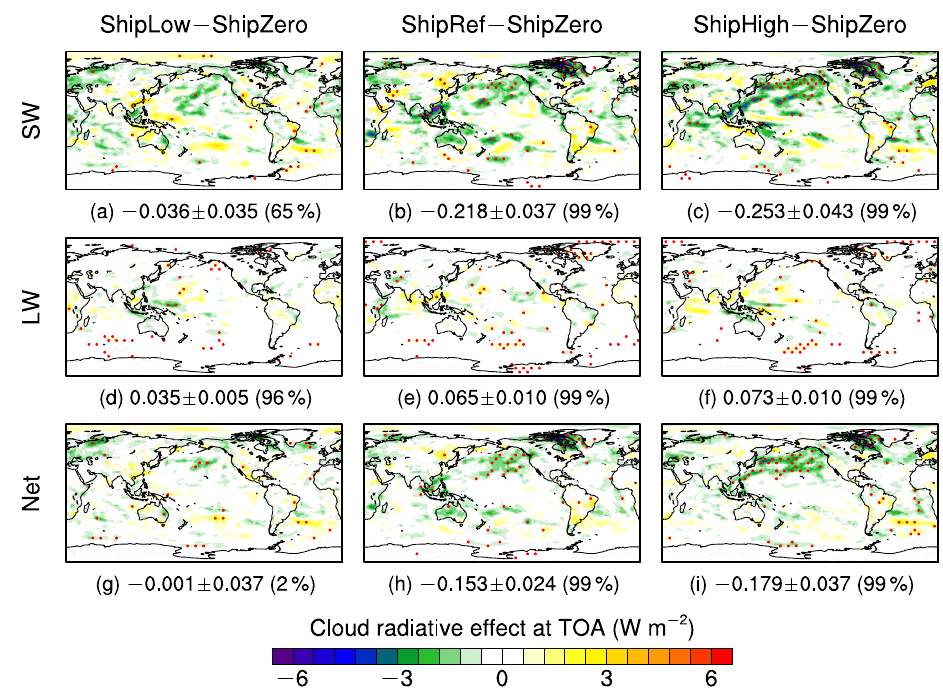
Figure 4. Spatial patterns of MARC-simulated cloud radiative effect (CRE; Wm − 2 ) at the TOA of ISE with various shipping emission levels. The CRE is calculated as the differences of radiation flux at the TOA and at all-sky conditions between the simulation without shipping emissions and three simulations with the same DMS emissions at the reference level but various shipping emission levels (i.e., low, reference, high) in short-wave (SW), long-wave (LW), and net (SW + LW) radiation and averaged over the 30-year simulation period. The numbers below each panel are the global means, standard deviation across the 30-year period, and the confidence level. The red dots represent grid points that are statistically significant above the 90% confidence level based on the two-tailed Student’s t test.